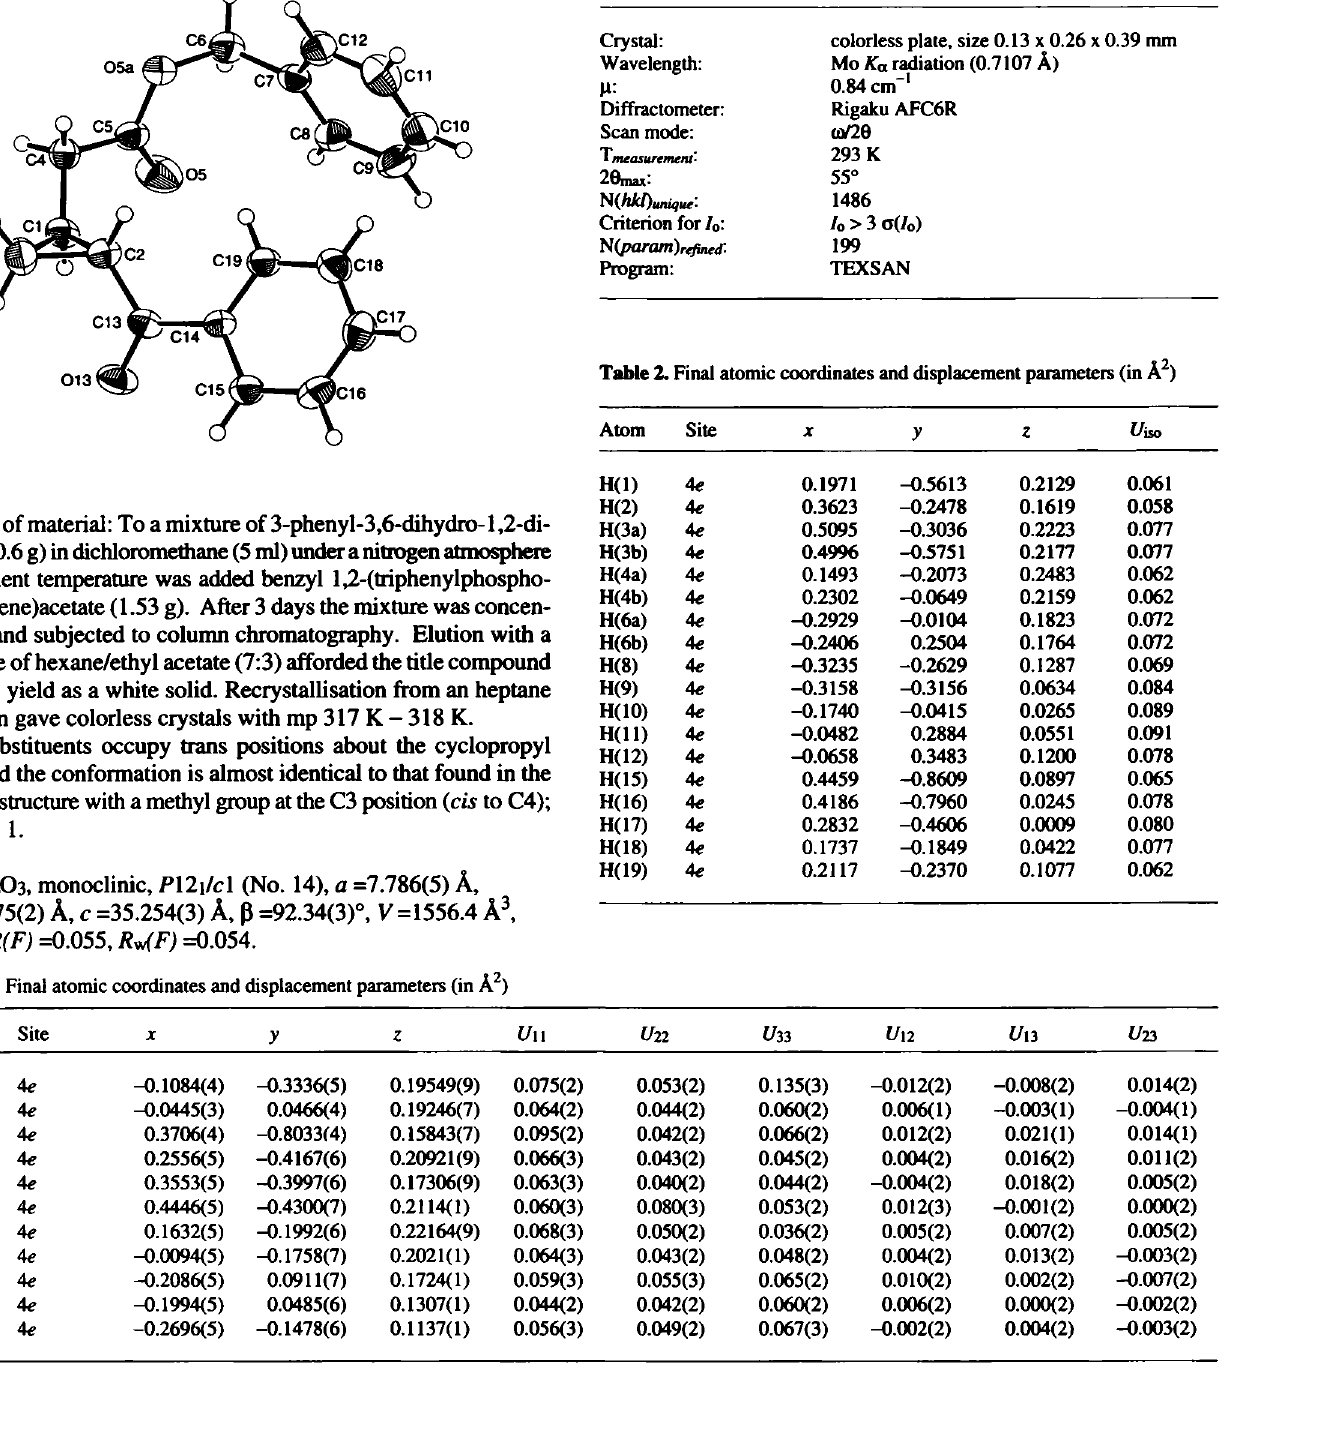
Table 1. Parameters used for the X-ray data collection